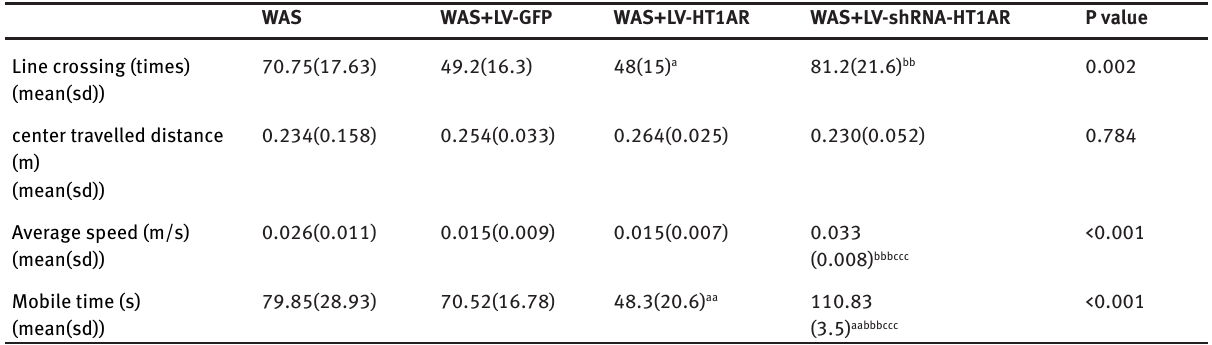
Table 1: Comparison of anxiety-like behavior among different HT1AR intervention